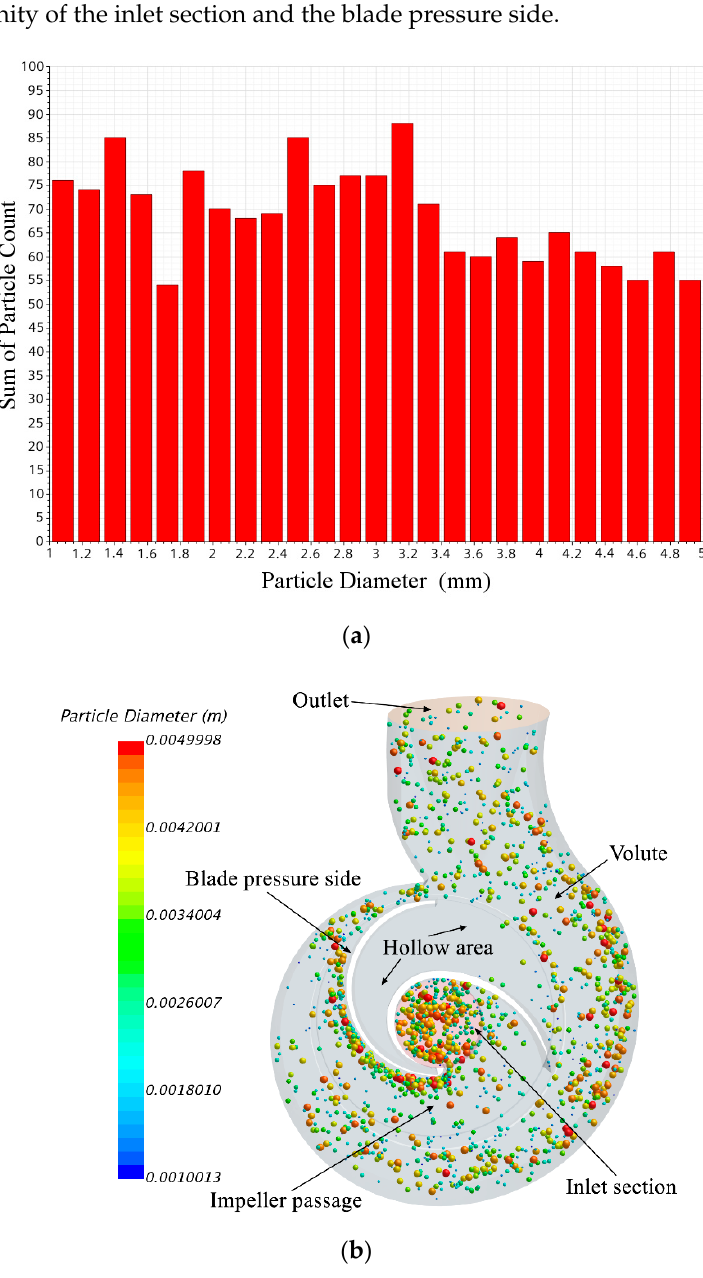
Figure 6. Particle size distribution ( a ) and trajectory ( b ) mixed ‐ size particles.